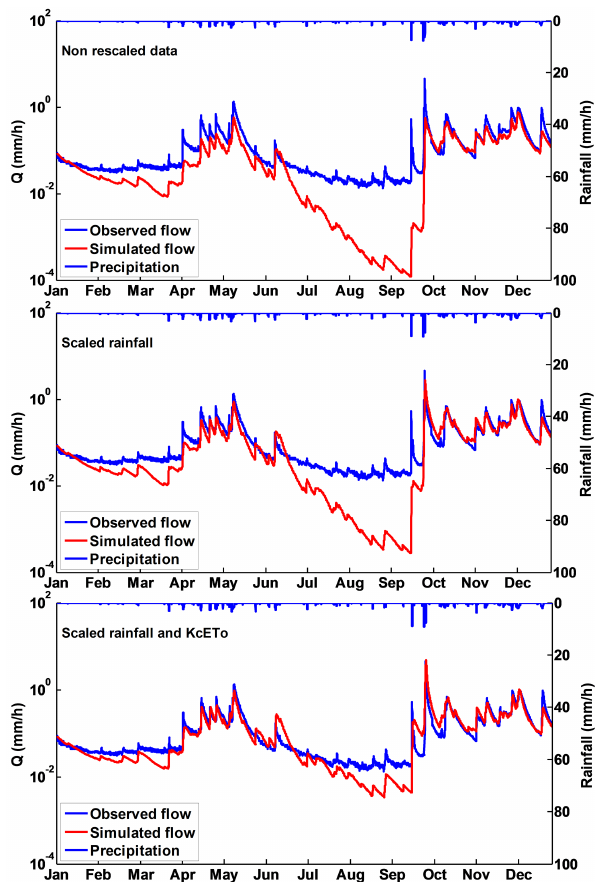
Figure 11. Series of simulated hourly hydrographs (red) for Al- tier at Goulette (#4) catchment for the year 2000 and its compari- son with observed discharge (blue), using original non-scaled data (top), with rescaled P only (middle), and rescaled P and K c ET 0